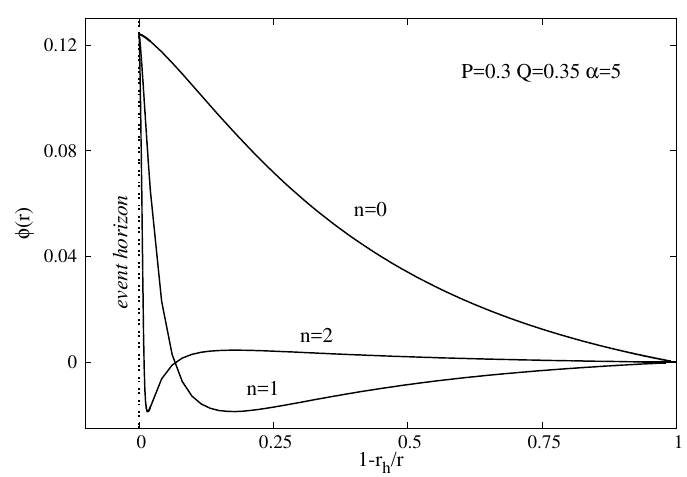
Figure 6 . A sequence of scalar (cid:12)eld pro(cid:12)les starting with the same horizon data in a scalarised model. Each solution possesses a di(cid:11)erent node